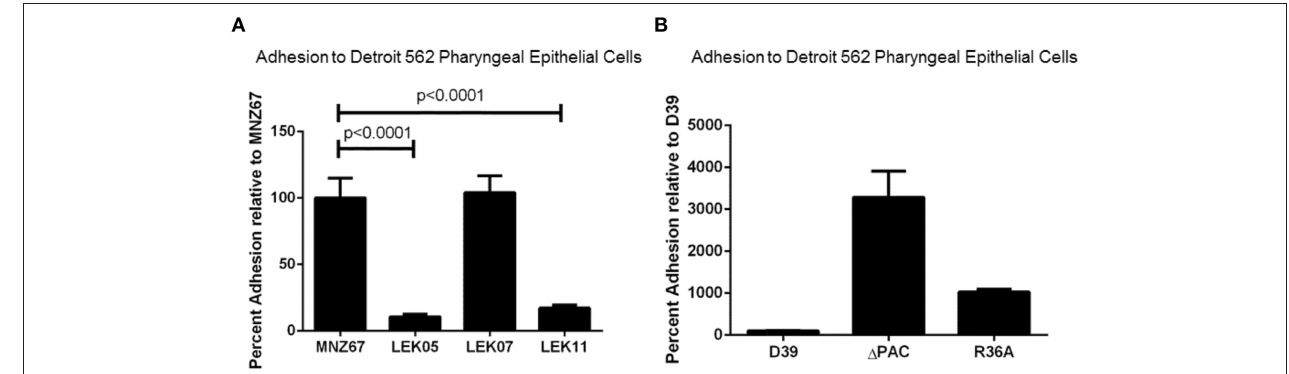
FIGURE 2 | Adhesion of pneumococci to human pharyngeal epithelial cell line Detroit 562 is affected by specific gene deletions. (A) Deletion of pspK from wildtype NESp MNZ67 significantly reduced bacterial adhesion to epithelial cells, but no effect was seen with a ply gene deletion. Deletion of pspK and ply from MNZ67 (LEK11) significantly reduced epithelial cell adhesion compared to wildtype MNZ67 ( p < 0.0001). (B) Pneumococcal epithelial cell adhesion was significantly increased in both D39 mutants, 1 PAC and R36A ( p < 0.0001). Data represents three independent experiments in triplicate.